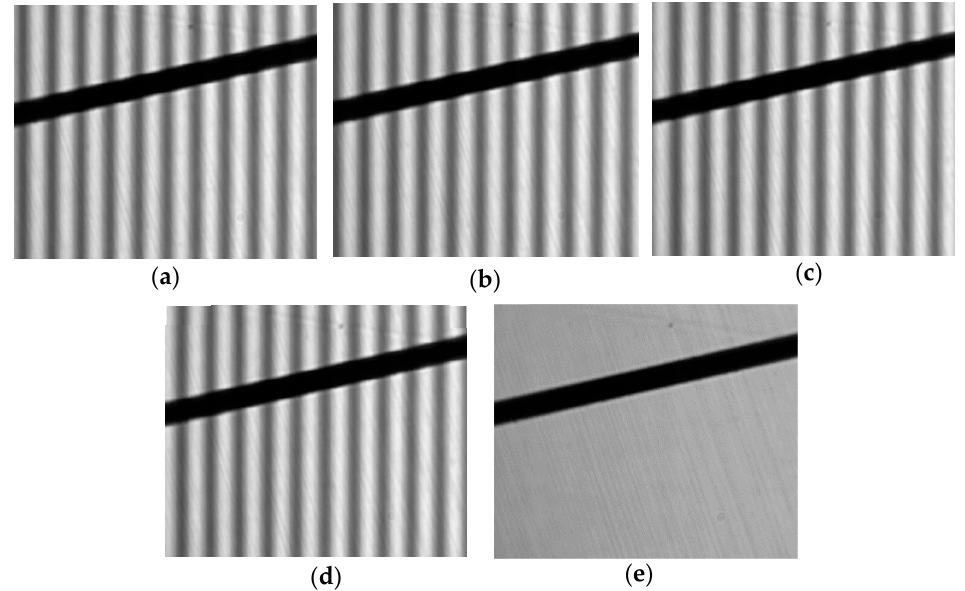
Figure 9. Phase-shifted images acquired from four-step phase shifting operation and image summing algorithm: ( a ) Phase-shift 0°; ( b ) Phase-shift 90°; ( c ) Phase-shift 180°; ( d ) Phase-shift 270°; and ( e ) Image result of average 4 channels.